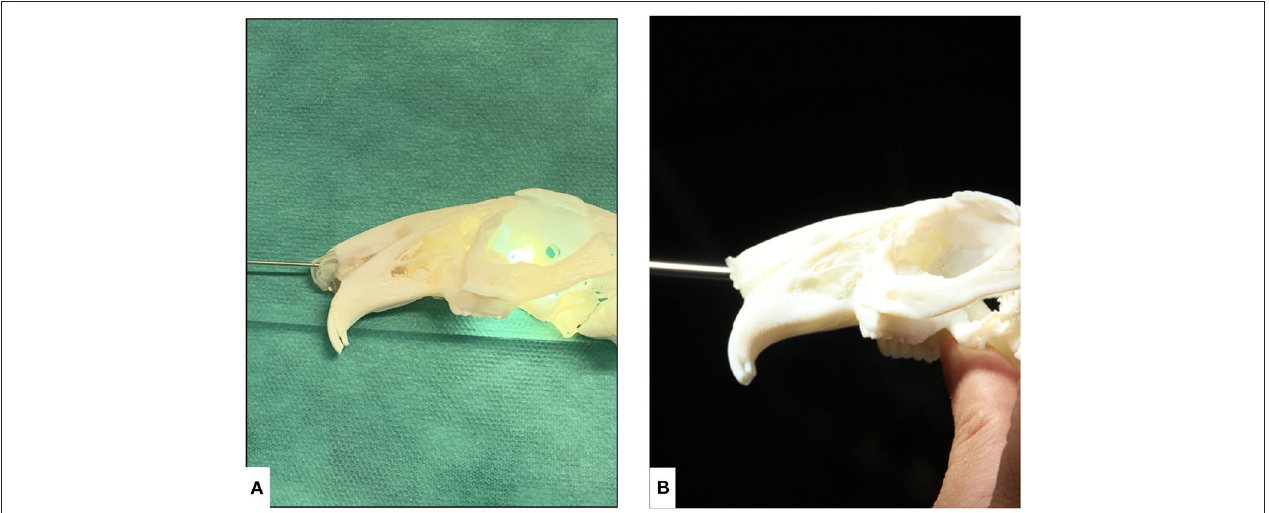
FIGURE 4 | Radiodensity evaluation of skeletal and mucosal parts of the additively manufactured rabbit nasotracheal airway models using Analyze12.0 toolkit. The yellow arrow is a line profile that measures the gray value corresponding to the radiation attenuation of all points on the line. (A) Sagittal section of the CT scan of the µ CT-derived model and (B) sagittal section of the CT scan of the CBCT-derived model.